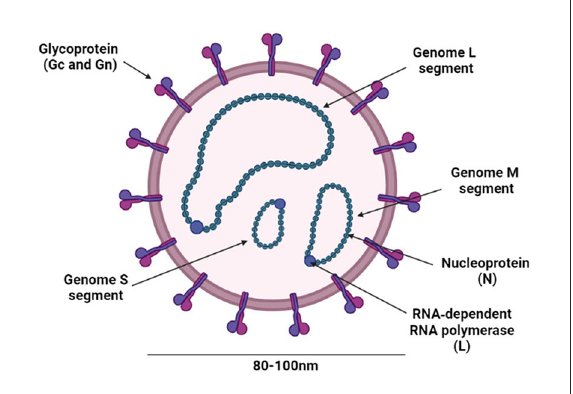
FIGURE4 Schematic representation of the CCHFV structure. The figure was created with BioRender (https://Biorender.Com/).